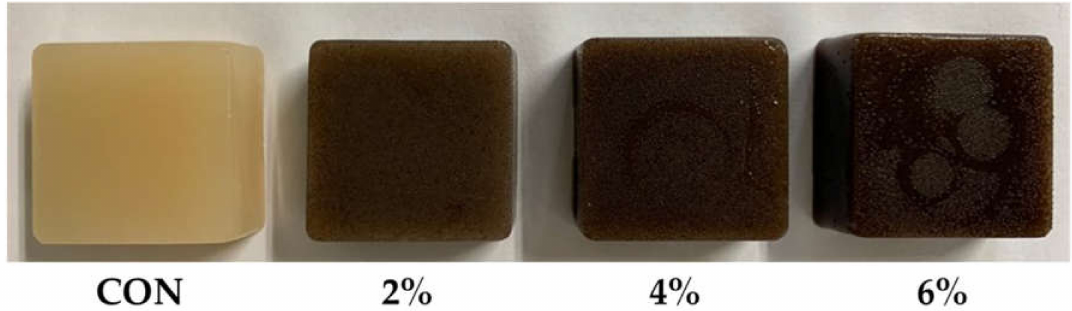
Figure 1. Appearance of Yanggaeng treated with Corni fructus